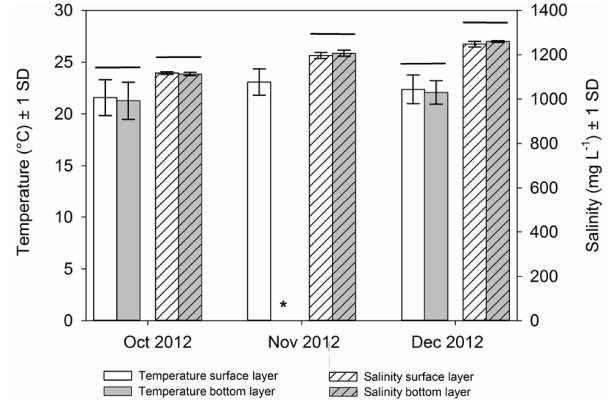
Figure 2. Temperature ( ◦ C) and salinity (ppm) in the surface and bottom layers measured at seven sites over three months in Lake Yangebup during a previous study in 2012. “ ∗ ” indicates missing data; horizontal line indicates that no significant difference between layers were detected ( t -test) (from Song et al.,